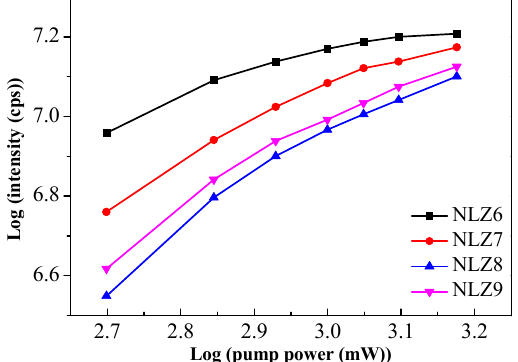
Fig. 7 Log–log plot of the green emission intensity versus the pump power of NLZ n ( n = 6, 7, 8,